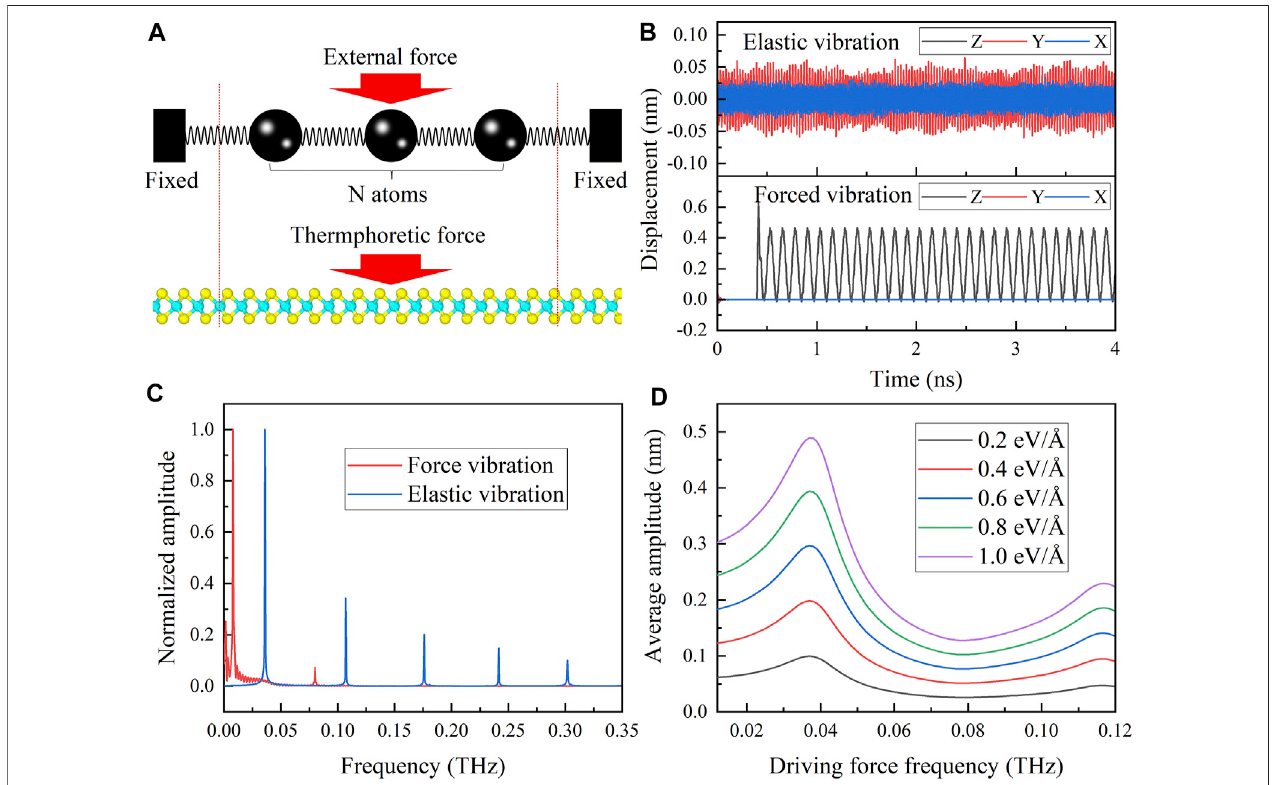
FIGURE 2 | (A) Model of the atomic chain and MoS (B) Vibration trajectory of the 2 nanoribbon with a periodic thermal driving force. Here, atom number N = 21. center atom in the range of 0 – 4 ns and 10 – 12 ns (inset), where the driving force amplitude F i =1, 0.5, 0.25 eV/Å and the corresponding frequency ω i = 0.008, 0.08, and 0.8 THz, respectively. (C) Vibration frequency distribution of forced vibration and elastic vibration (without external driving force and damping force). (D) Vibration amplitude of atomic chain versus the driving force frequency when the driving force amplitude F 1 = 0.2, 0.4, 0.6, 0.8, and 1.0 eV/Å,